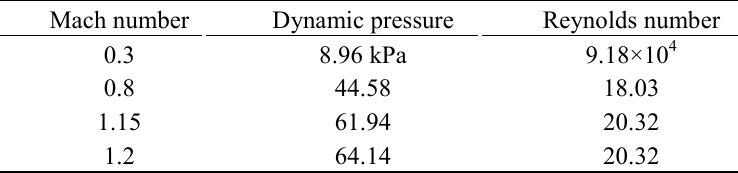
Table 2. Wind Tunnel Operating